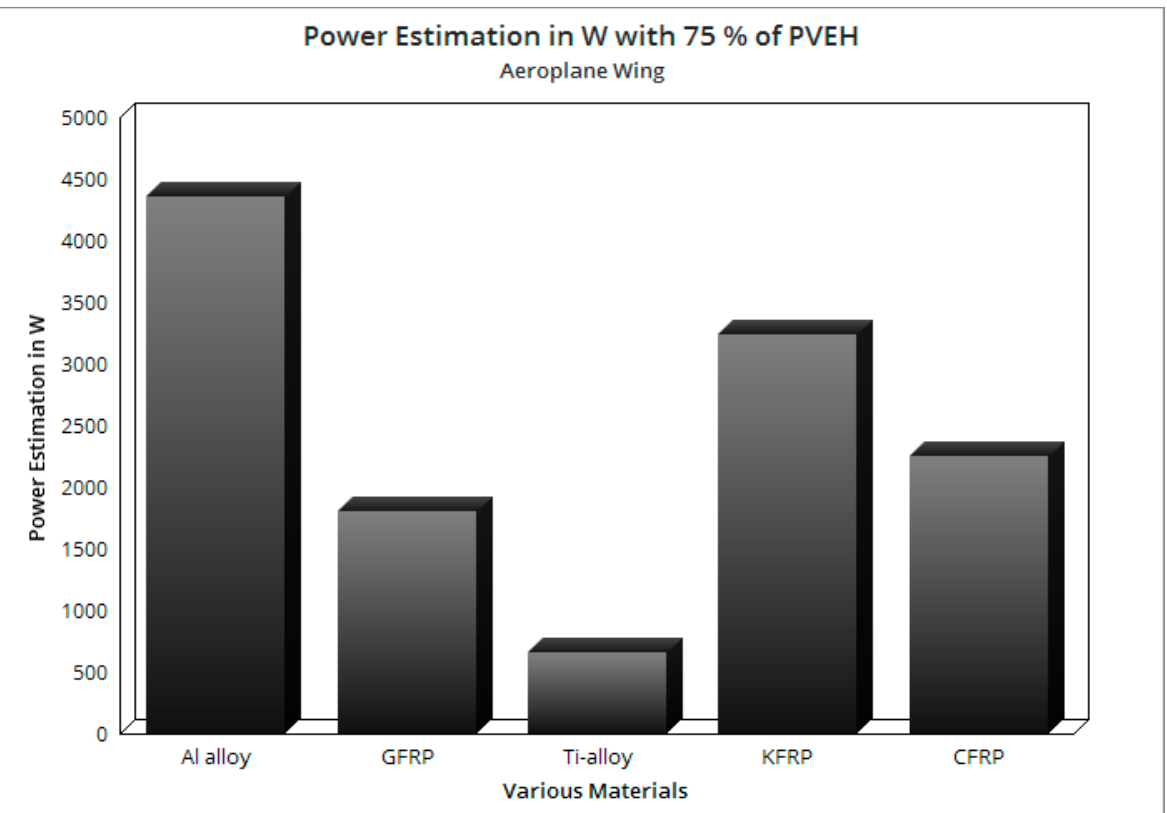
Figure 31. Power (P 0 ) in W with 75% attachment coverage—airplane wing.